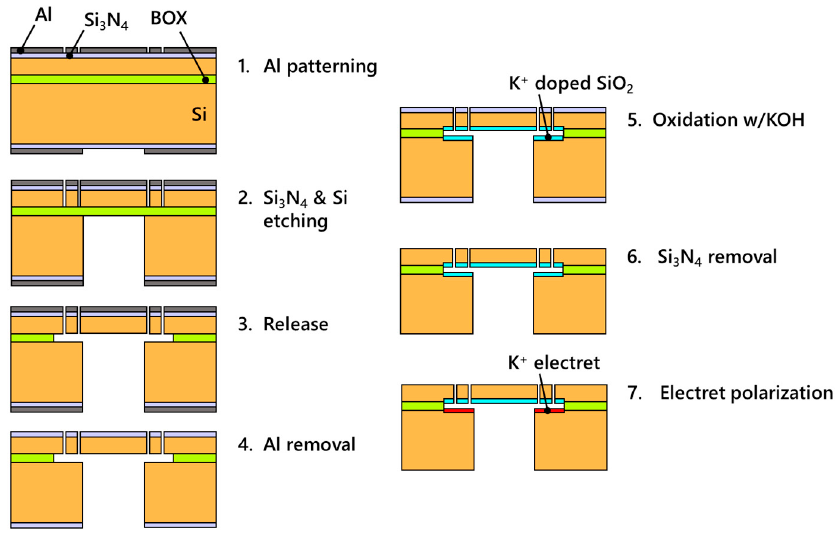
Figure 7. Process flow chart of out-of-plane membrane actuator.